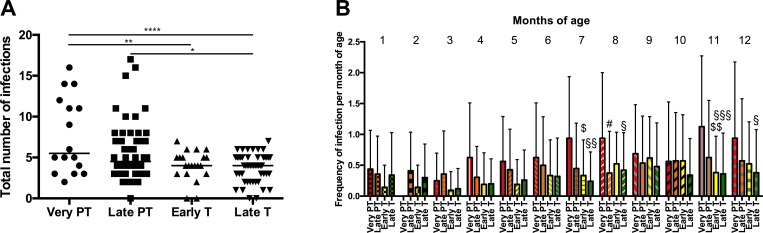
Number of infections in very preterm, late preterm, early term and late term infants.Infection number of respective groups within the first year are depicted in A. Frequency of infections are shown for each month of age for each group. PT: preterm, T: term, *adjusted p<0.05, ** adjusted p<0.01. ****adjusted p<0.0001. $ (very PT-early T): p<0.05, $ $ (very PT-early T): p<0.01, § (very PT-late T): p<0.05, §§ (very PT-late T): p<0.01, §§§ (very PT-late T) p<0.001, # (very PT-late PT): p<0.05.